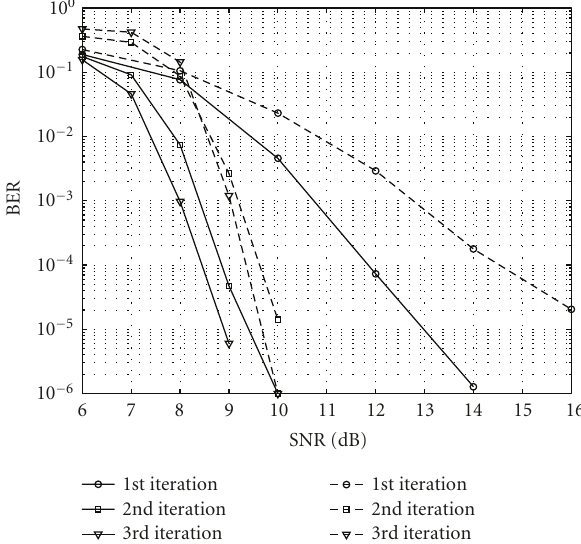
Figure 6: BER plot for time-invariant channel. The solid line represents DFE-Turbo BICM and dashed line represents DFE-